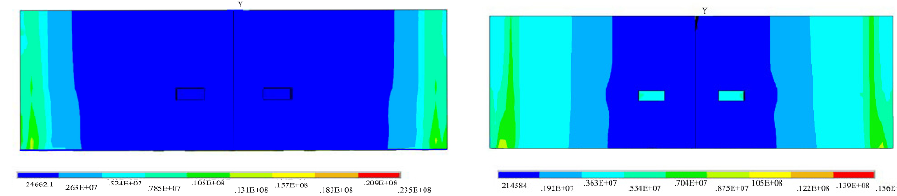
Figure 6. Failure process of the hand hole in the single-layer lining segment.